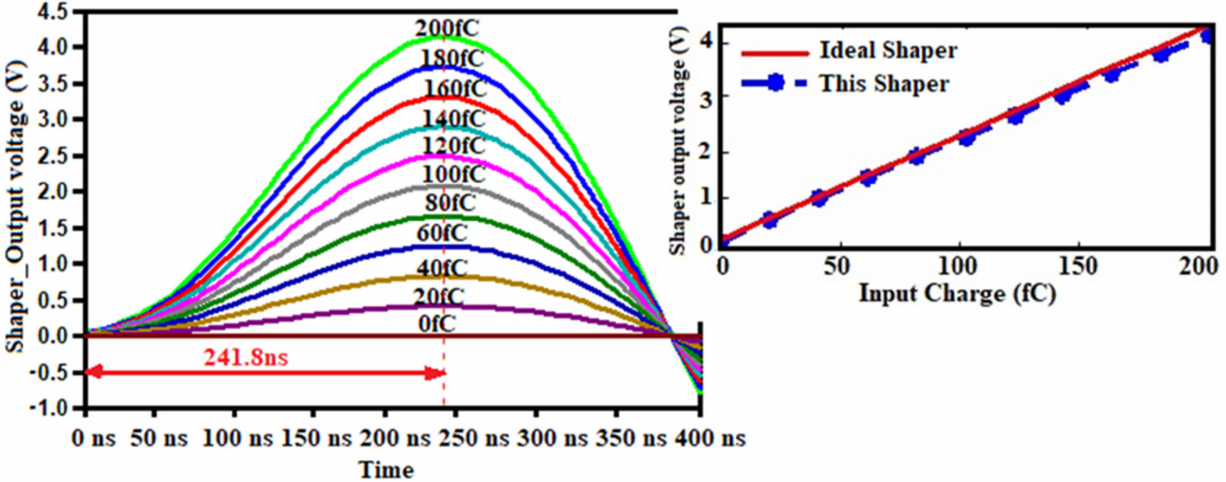
Figure 15. Pulse shaper (PS) output voltage for different input charge.